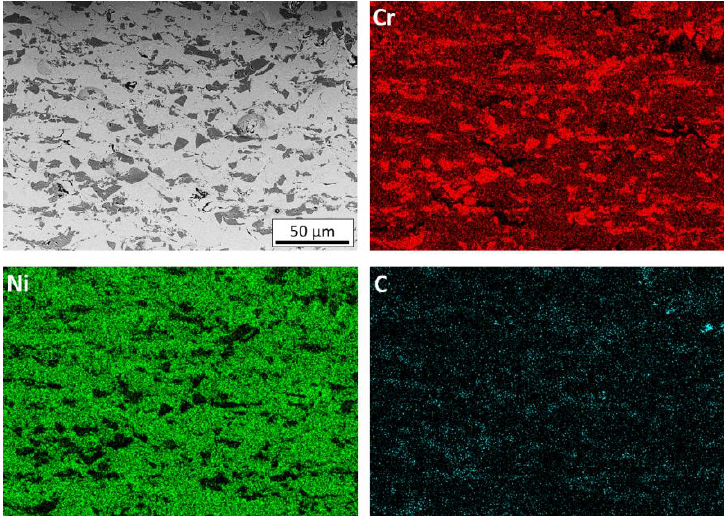
Figure 6. Cross-section and map of elements distribution (Cr, Ni, C) of the coating deposited with the parameter set 1 (SEM).